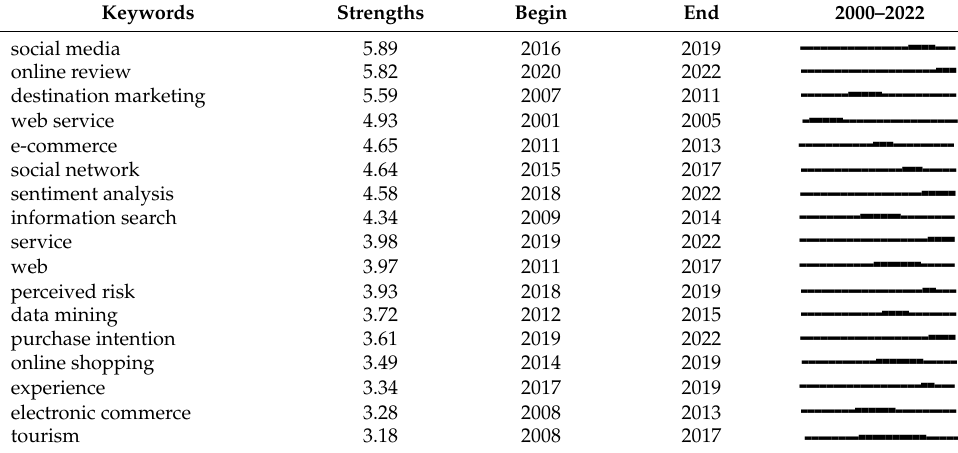
Table 4. Burst detection by keywords for electronic commerce.